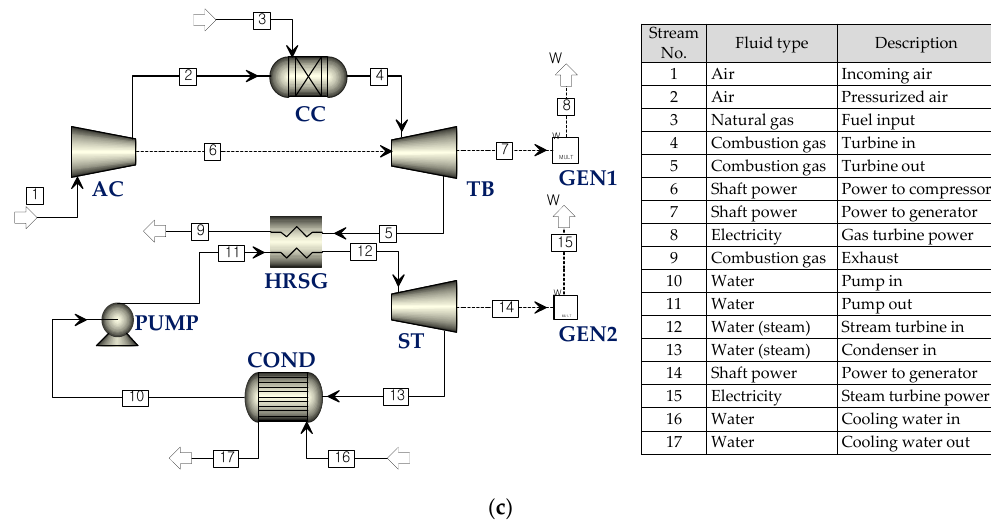
Figure 1. Flow diagrams of gas turbine power cycles: ( a ) gas turbine simple cycle; ( b ) gas turbine regenerative cycle; ( c ) gas turbine combined cycle. Abbreviations are defined as AC: air compressor, CC: combustion chamber, TB: turbine, GEN: generator, REG: regenerator, HRSG: heat recovery steam generator, ST: steam turbine, and COND: condenser.